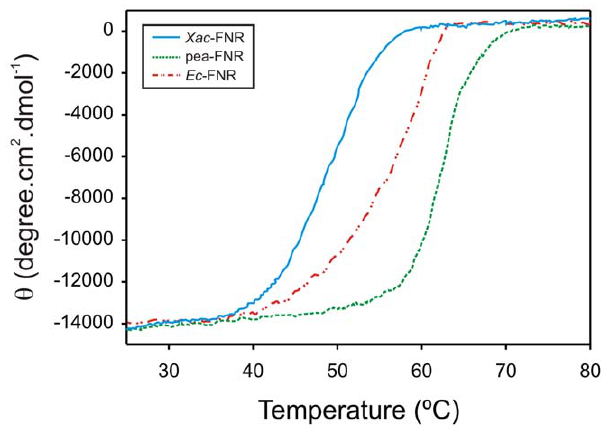
Figure 5. Thermal stability of the different plant-type FNRs according to the folding-unfolding transitions that were observed for the enzymes. Cyan, Xac -FNR; green, pea-FNR; and red, Ec -FNR.